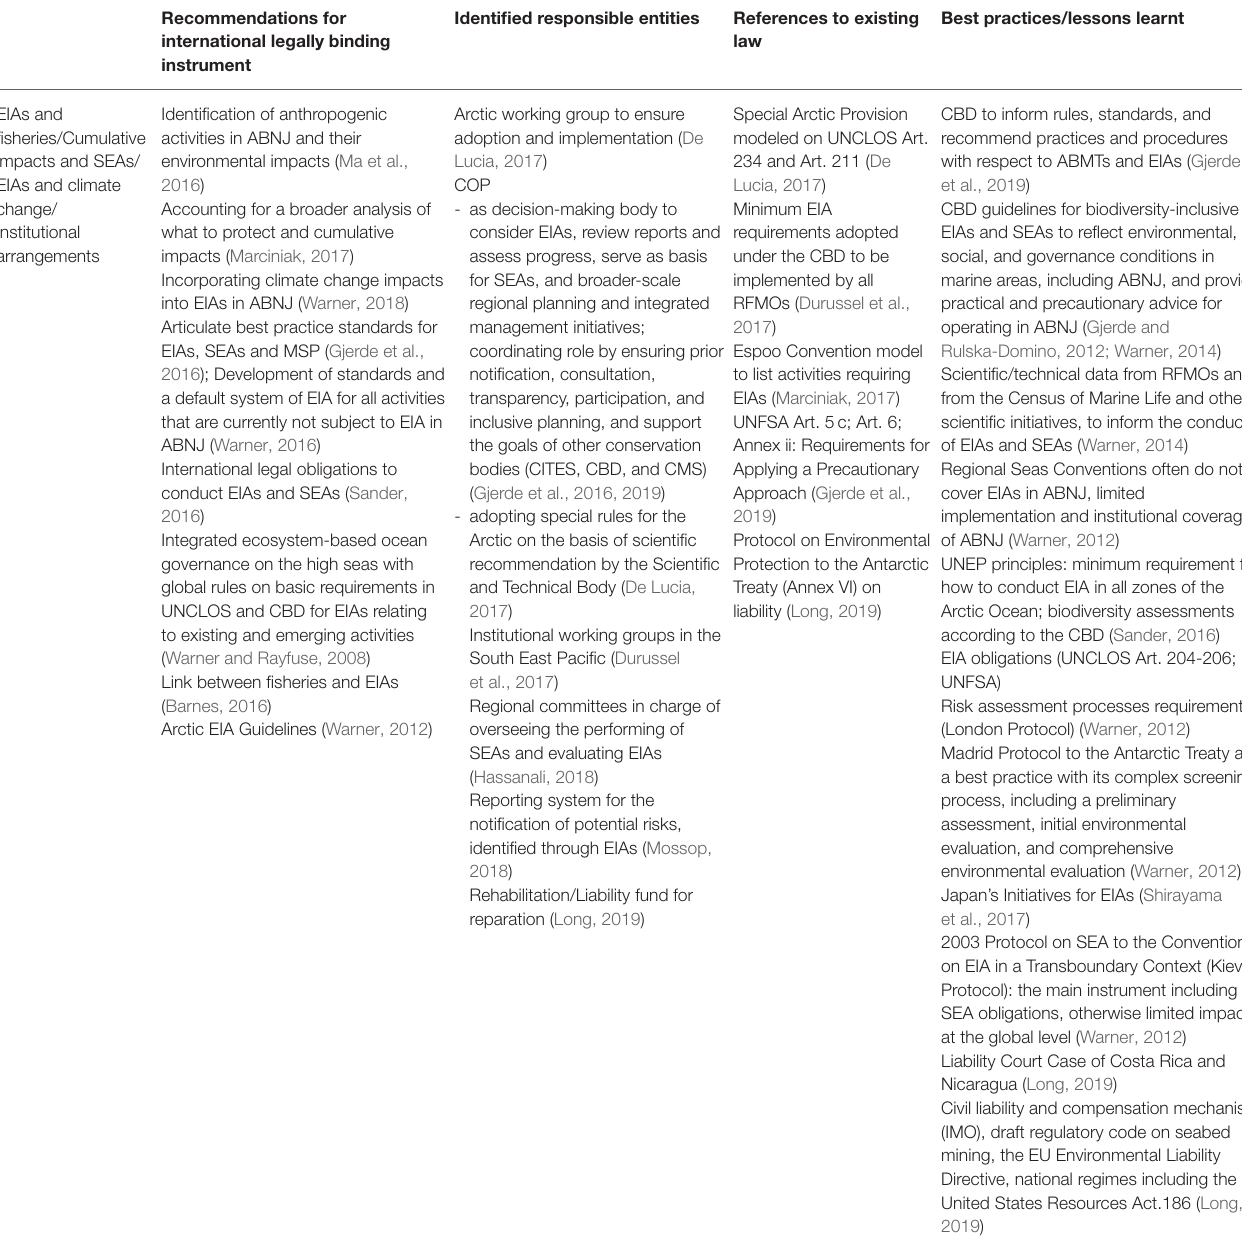
TABLE 5 | EIA BBNJ